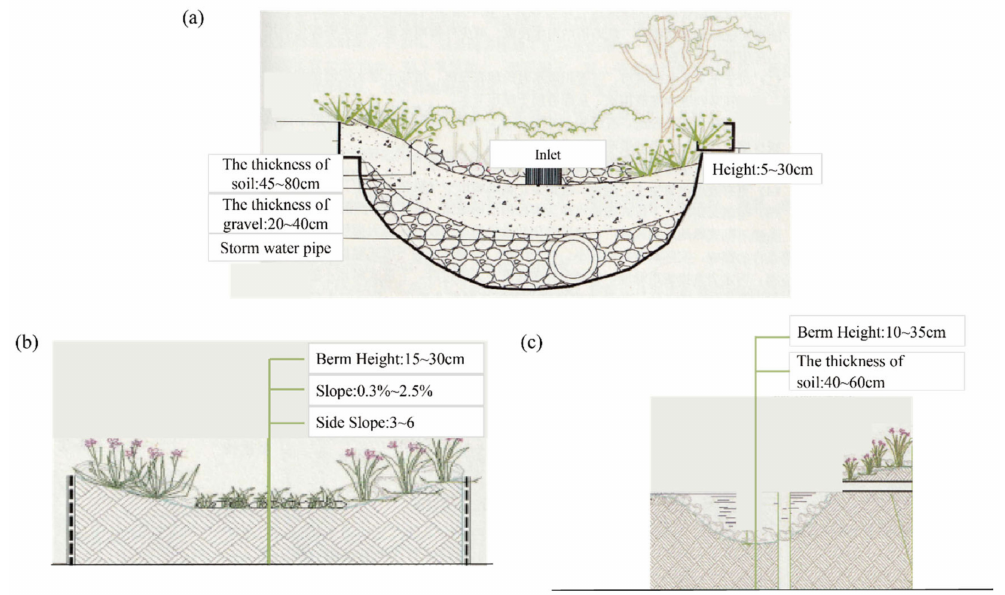
Figure 6. ThesizeofLIDsinthestudyarea. ( a )Sunkengreenspace; ( b )vegetativeswale; ( c )rainwatergarden. Table 4. The parameters of the LID facilities in a residential